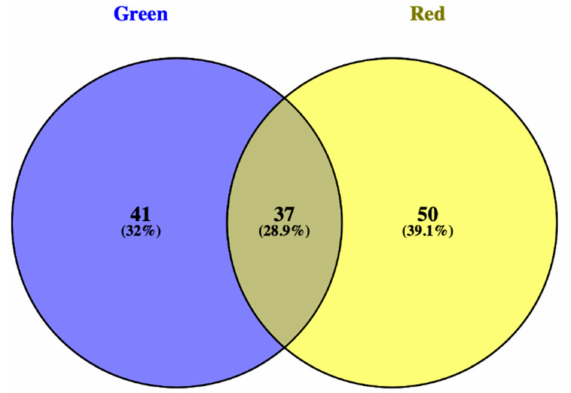
Figure 2. Venn analysis of variable importance in projection (VIP) compound (VIP > 1.1) common between red and green Salanova